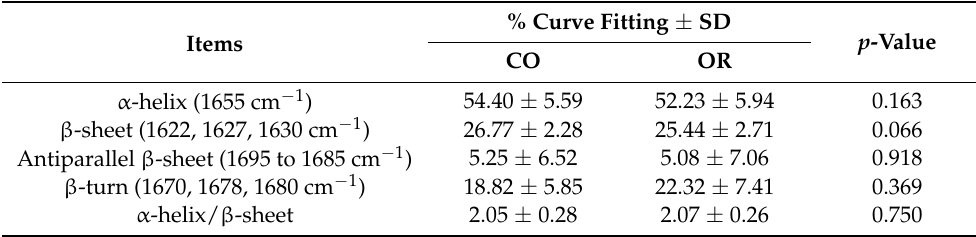
Table 9. Ratio of relative content of secondary structures determined by SR-IR from KRC organic chickens breast